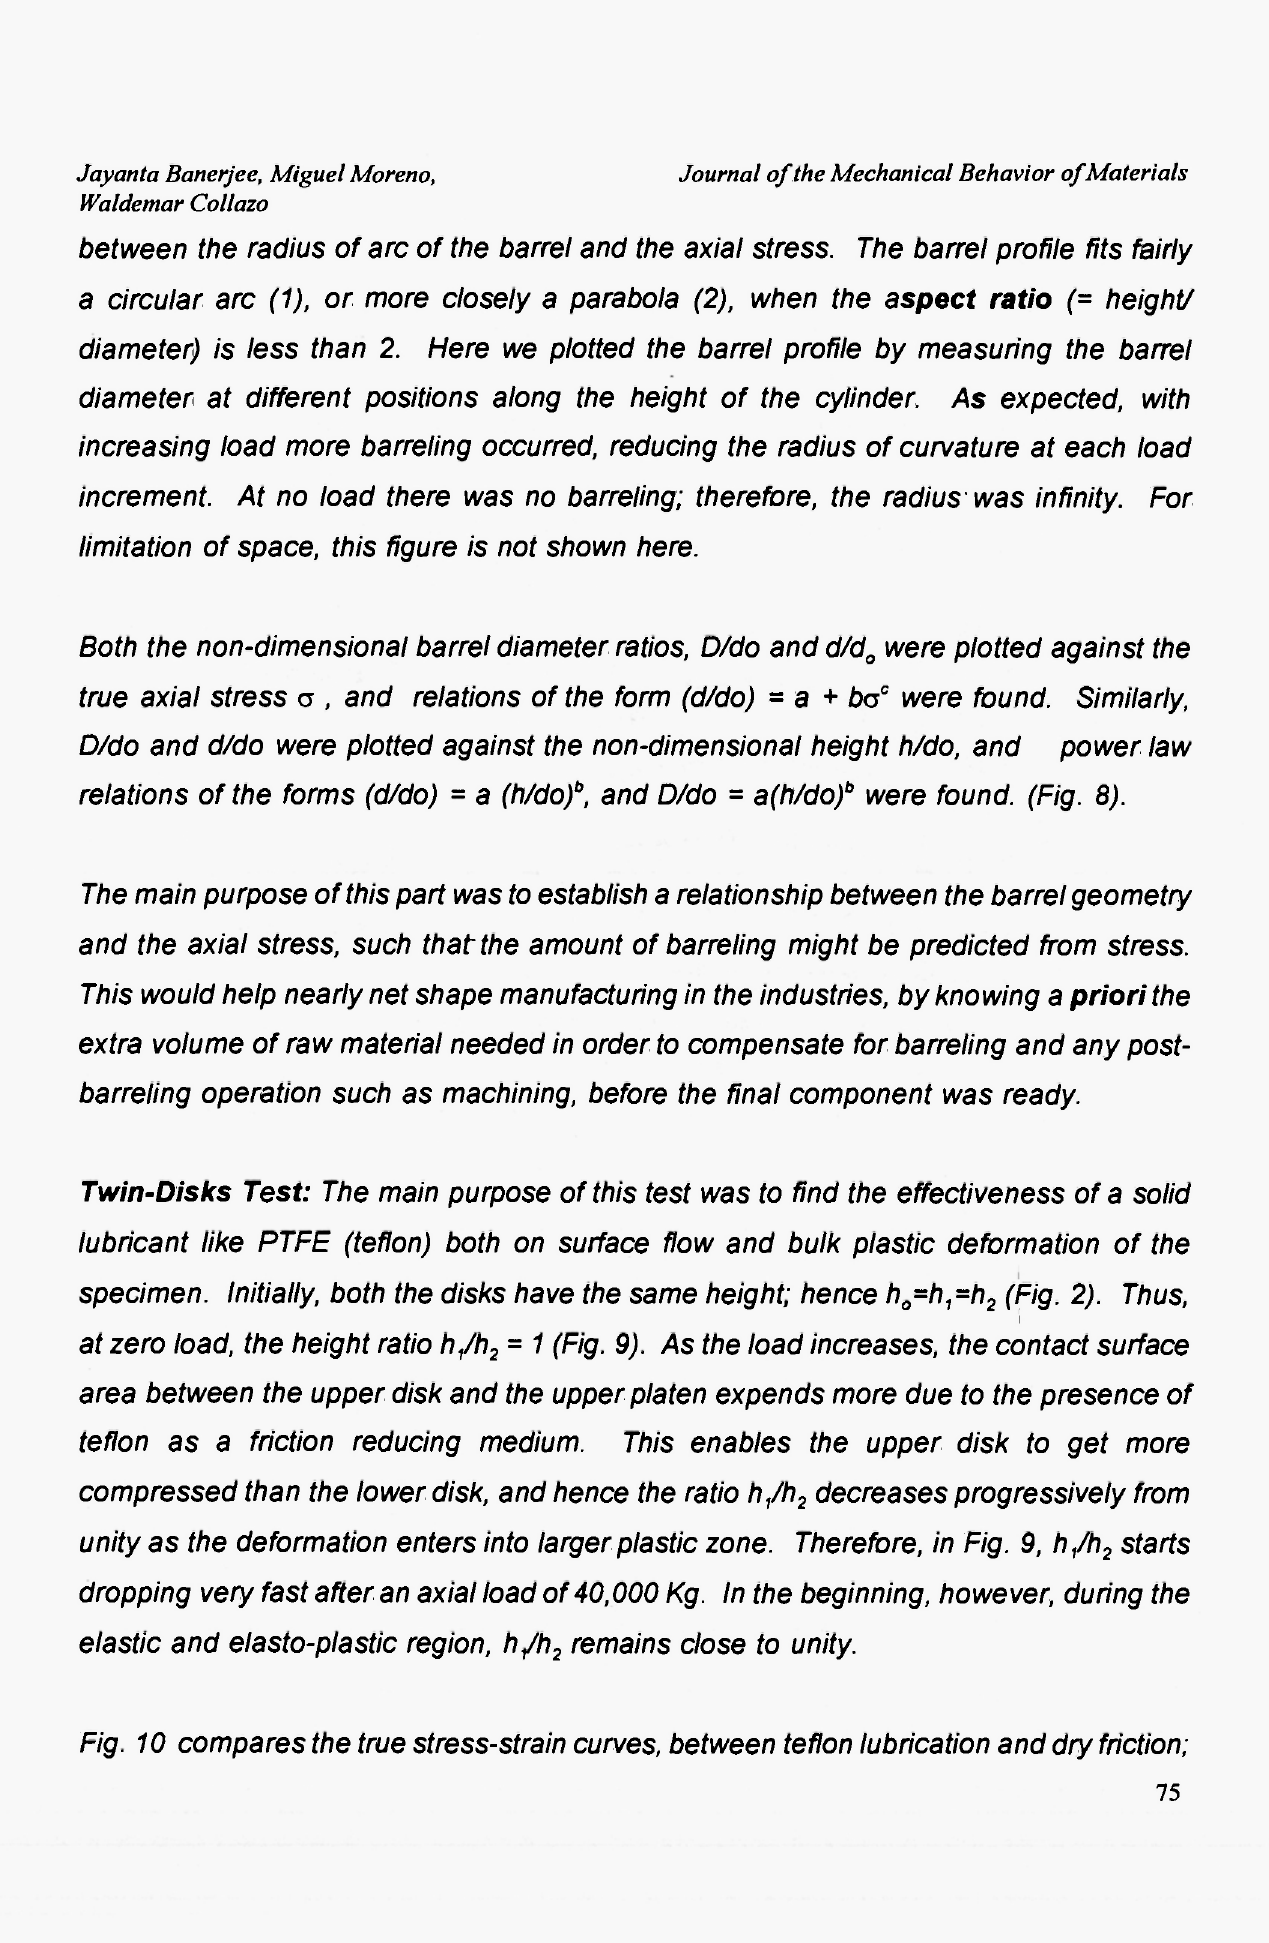
Fig. 10 compares the true stress-strain curves, between teflon lubrication and dry